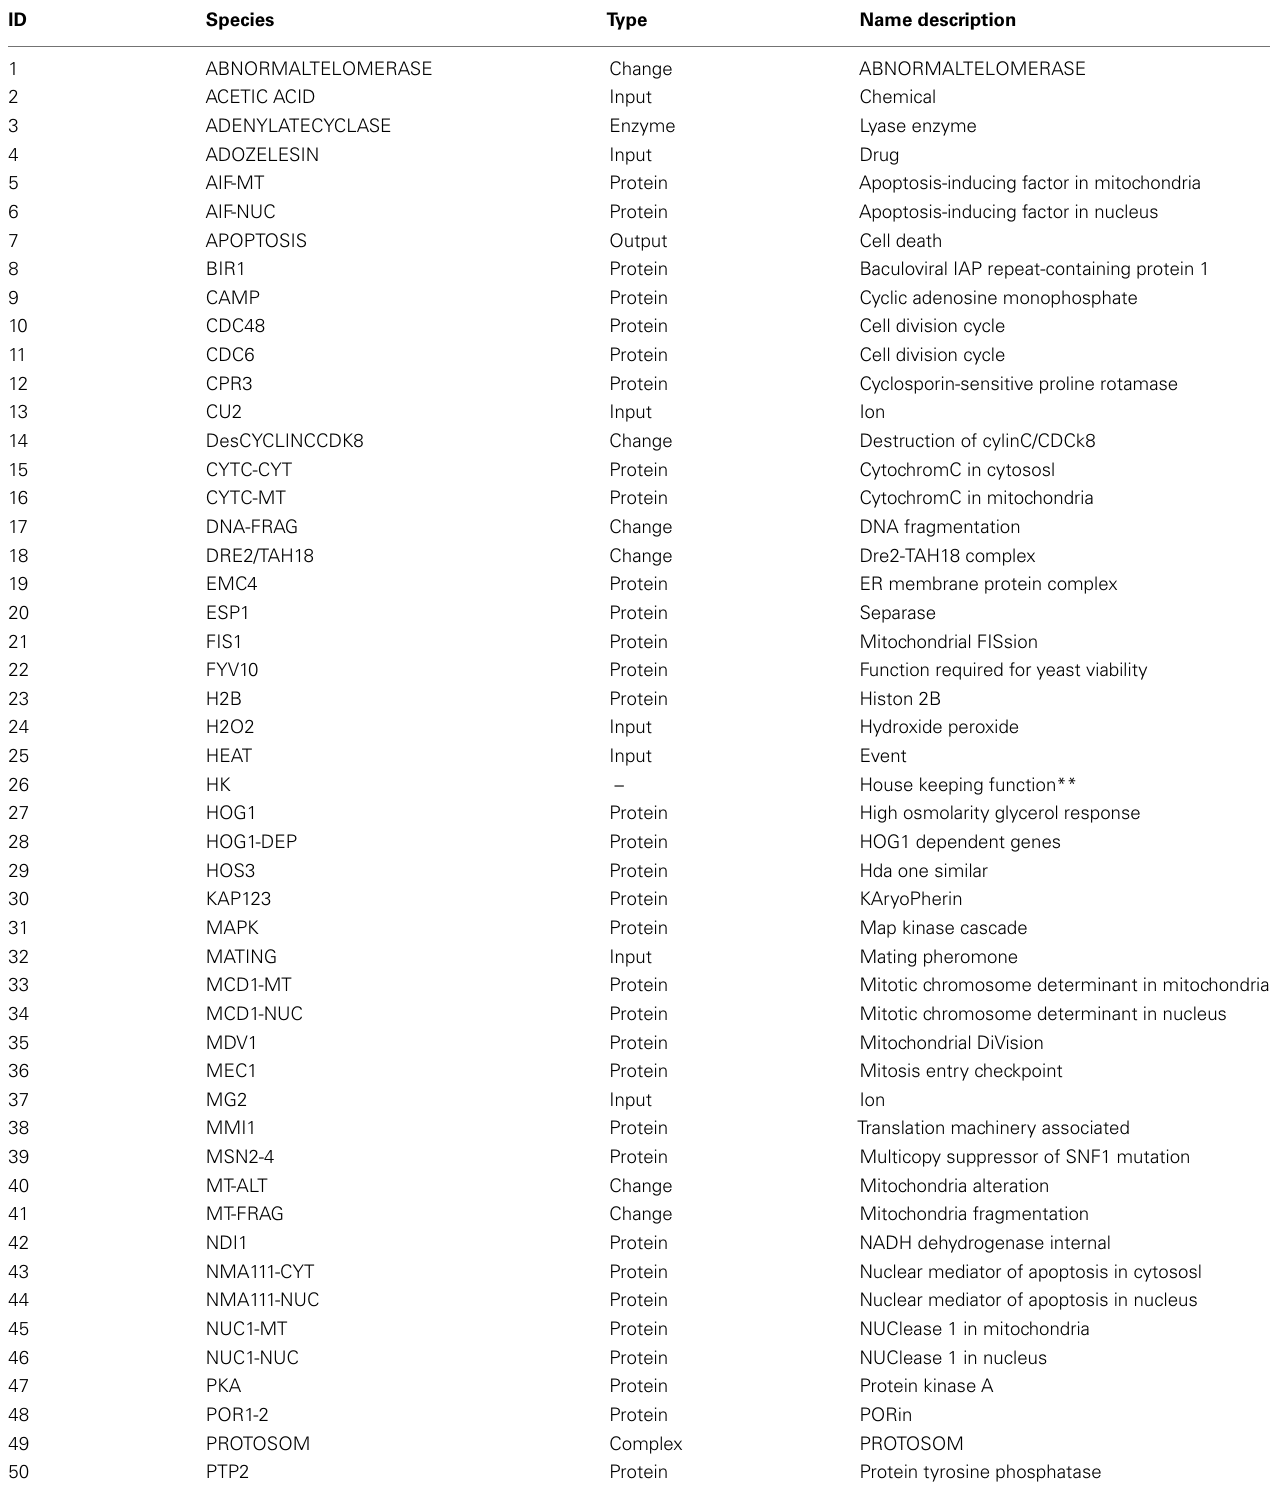
Table 1 | List of species in yeast Boolean